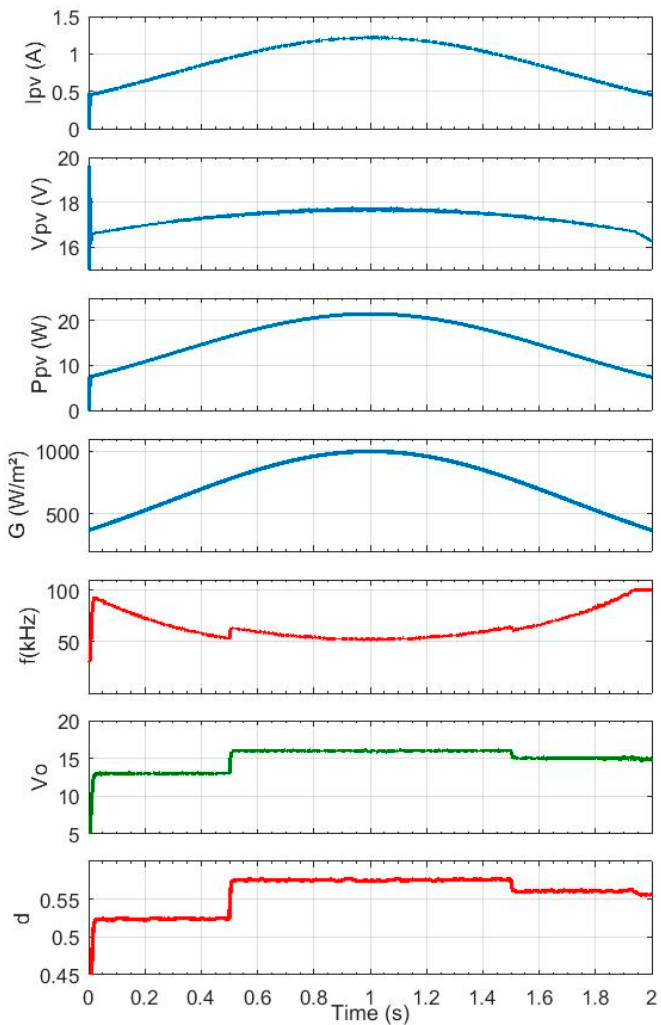
Figure 10. Simulation results for the conversion circuit based on a single switch S’ 1 (Figure 5, bottom). From top to bottom: I pv , V pv , P pv , G , f , V O and D .